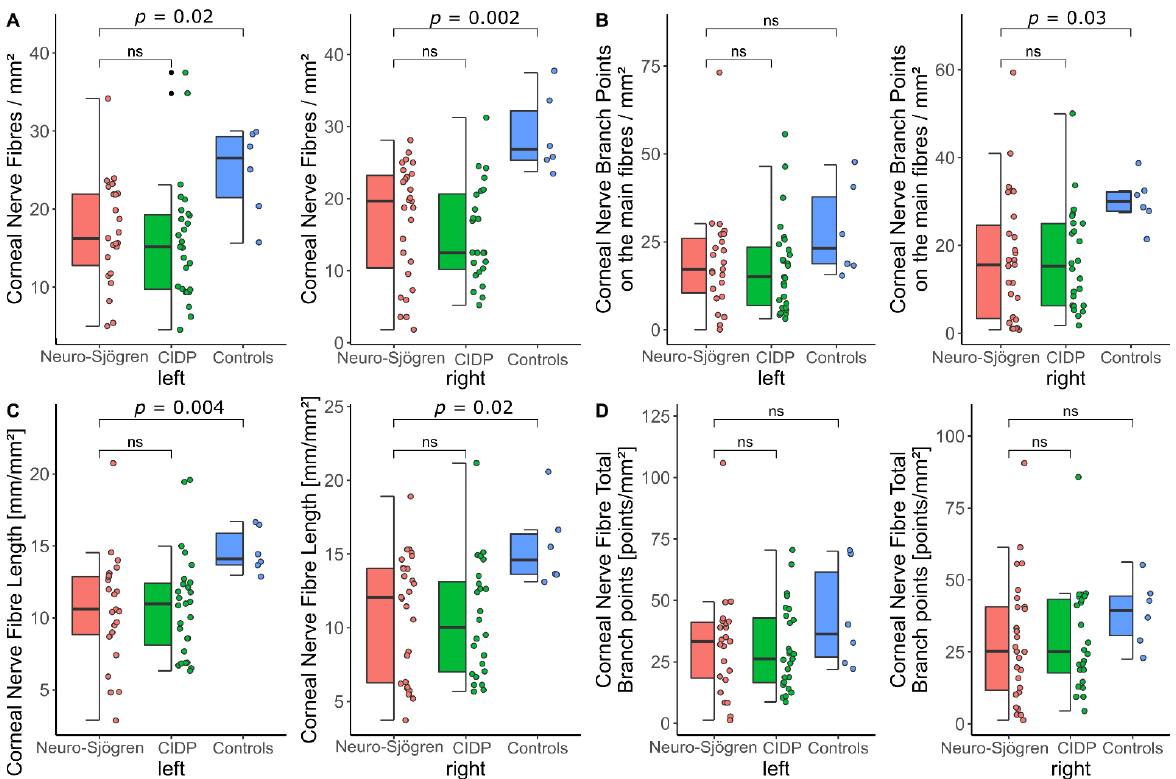
Figure 1. Confocal microscopy parameters with significance levels at in-between group differences for patients with Neuro-Sjögren (red), chronic inflammatory demyelinating polyneuropathy (CIDP, green) and controls (blue): ( A ) corneal nerve fibre density; ( B ) corneal nerve fibre main branch density; ( C ) corneal nerve fibre length (total length of nerves); ( D ) corneal nerve fibre total branch density; ns: not significant.